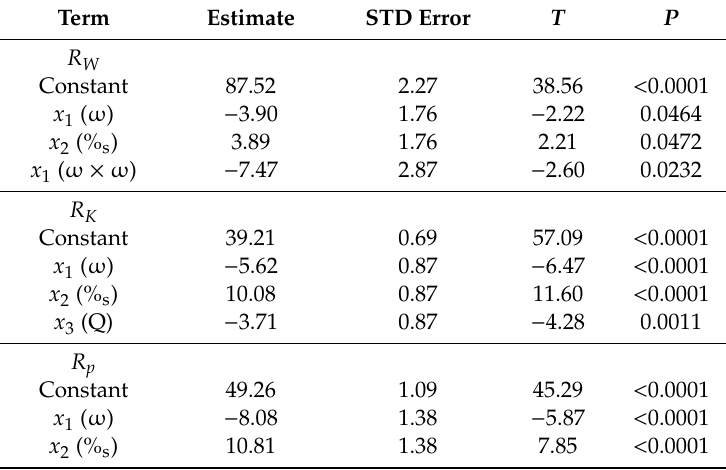
Table 5. Parameter estimates for the final models for the Falcon UF as a function of the